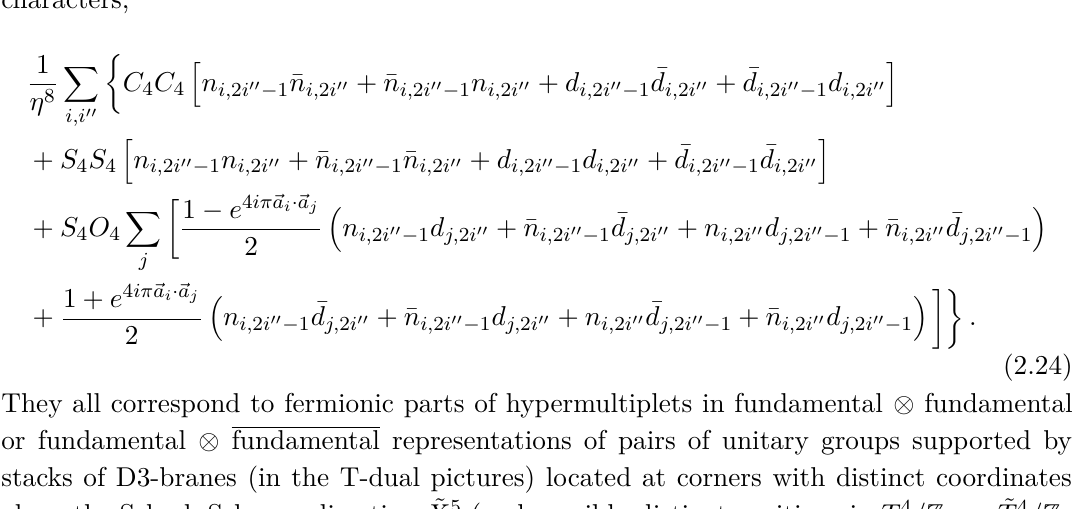
JHEP12(2021)022